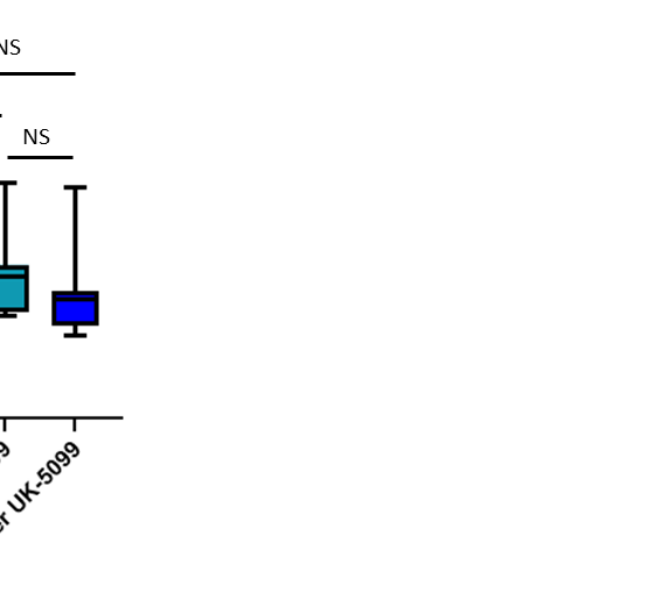
Figure 8. Evolution of pHe (estimated by 31 P-NMR spectroscopy) in 4T1 tumors in mice before and after treatment 4 days with DMSO (control) or UK-5099 (NS: not significant, paired t -test, n = 8 for each group).